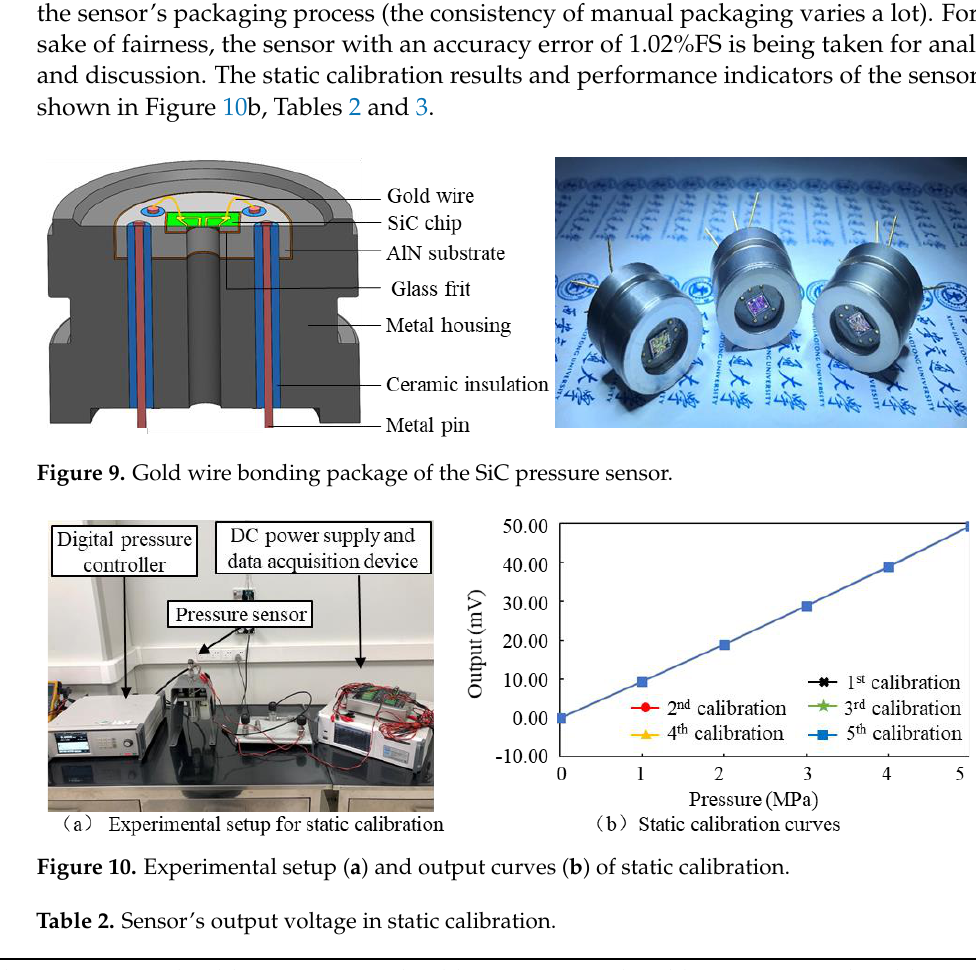
Figure 8. ( a ) SEM photograph of back cavity morphology after femtosecond laser etching, ( b ) SiC sensor chip and surface roughness test result.